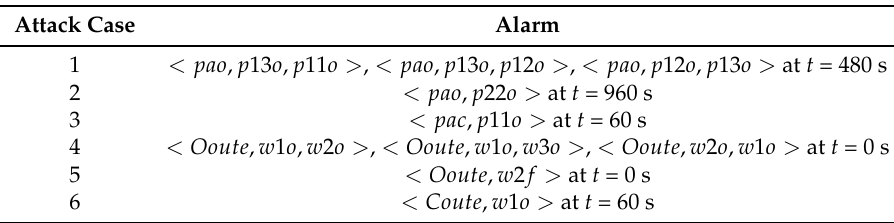
Table 4. Broken correlations under